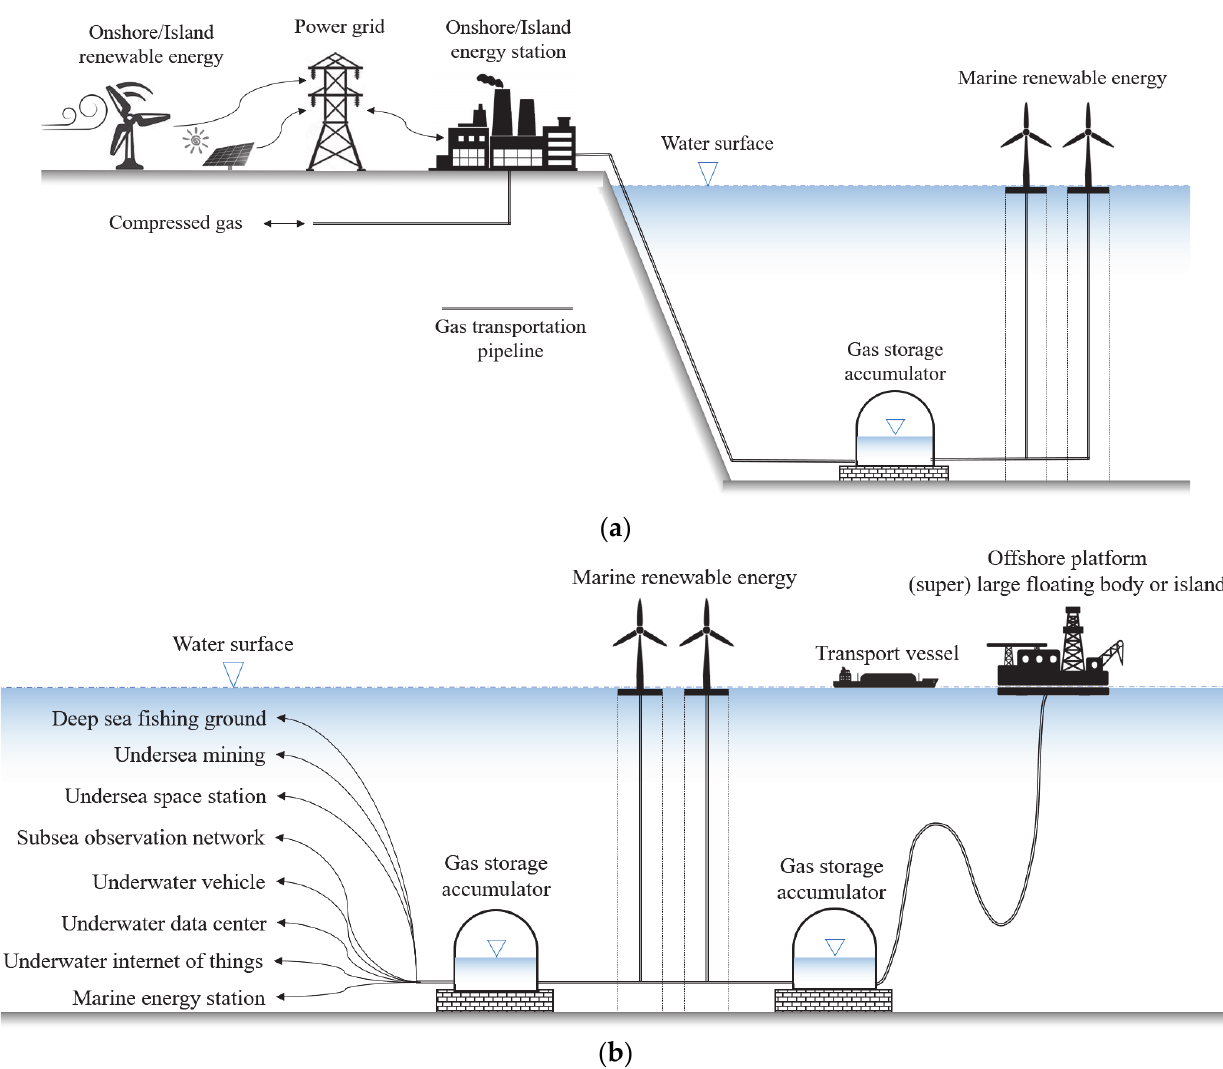
Figure 6. Potential application scenarios of UWCGES: ( a ) Short term service scenarios; ( b ) Medium and long term service scenarios.